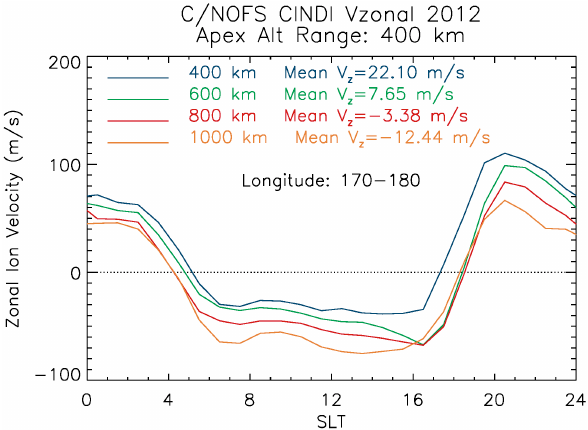
Figure 11. CINDI zonal ion drift versus SLT in the 170 ° –180 ° longitude range for 2012 in four different apex altitude ranges. Each of the ranges begin at the lower bound indicated and extends upwards 400 km.